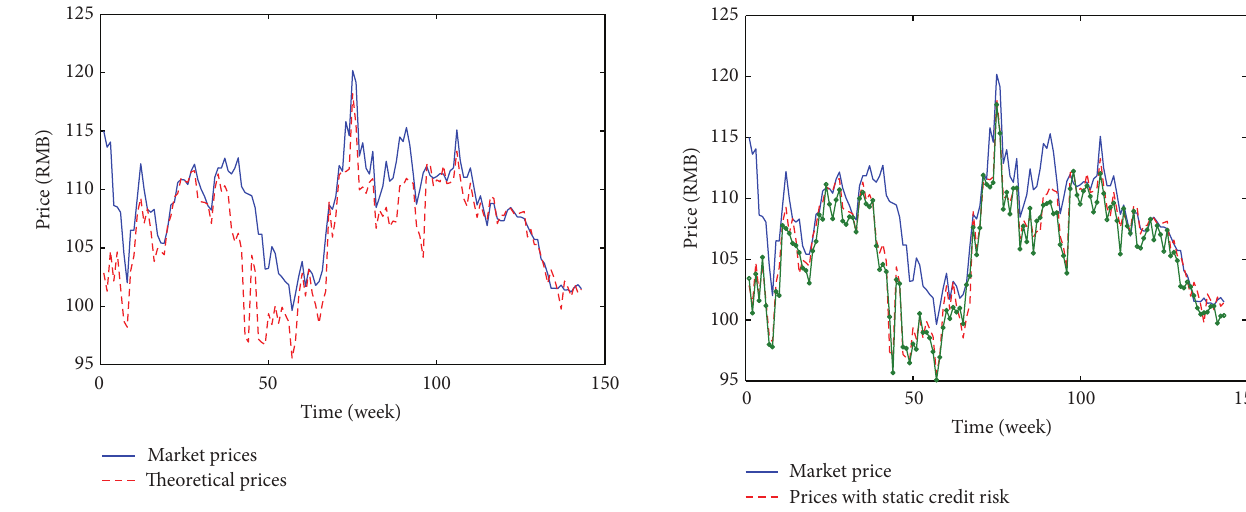
Figure 1: Comparison of the theoretical and market prices of ICBC convertible bond.